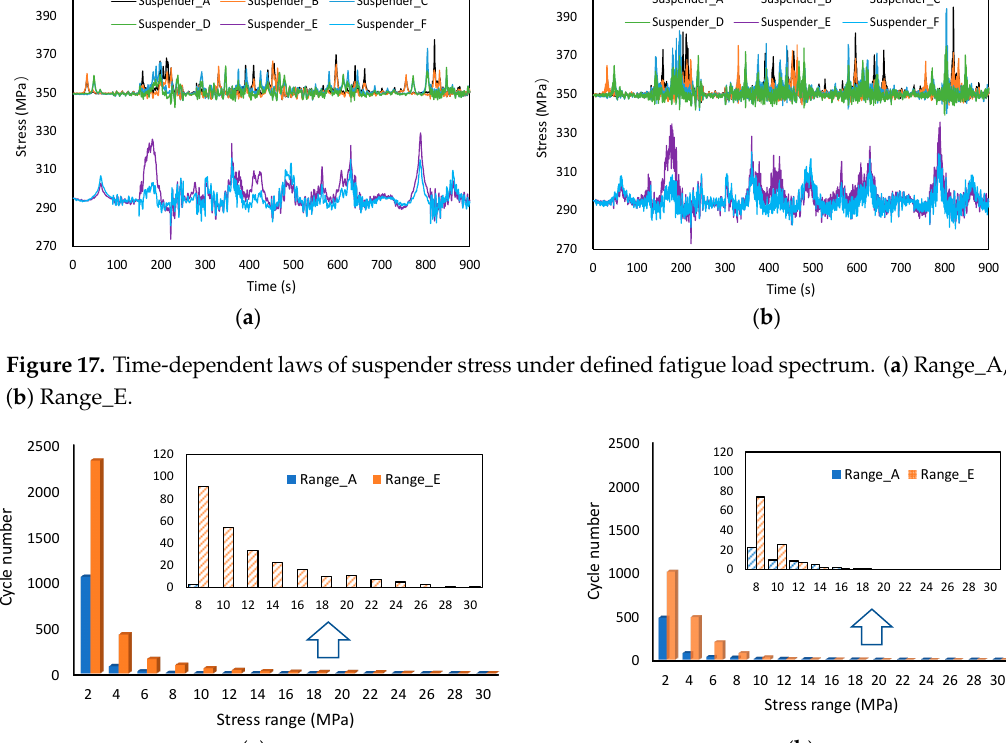
Figure 18. Counting results of different stress range by the Rain flow counting method. ( a ) Suspender A, ( b ) Suspender E.